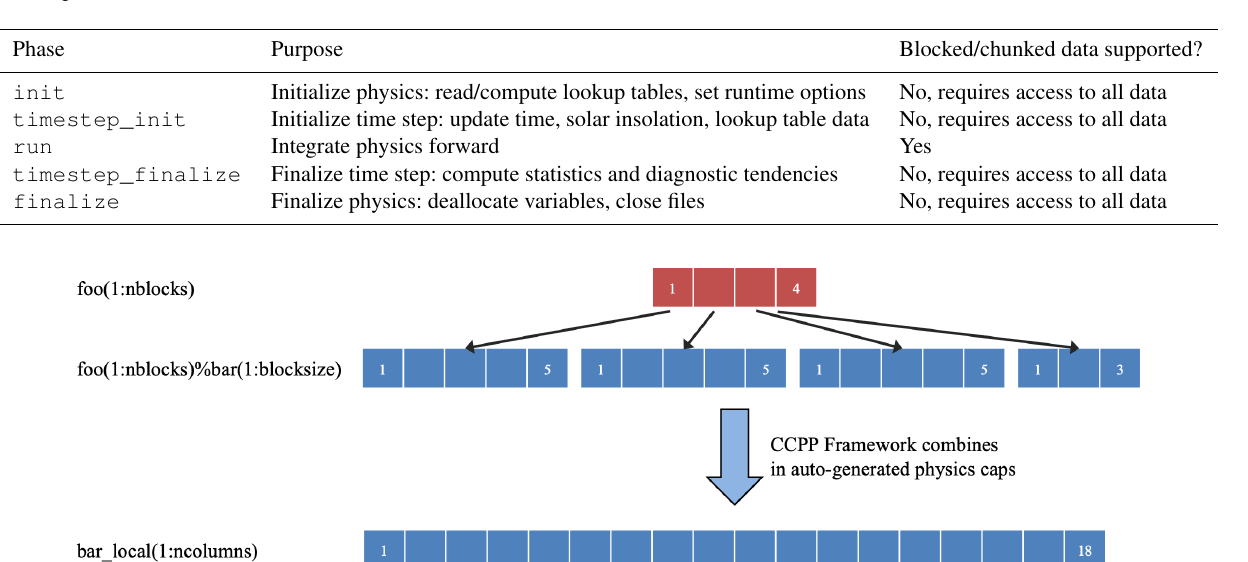
Table 1. Supported phases during a model run. The third column contains information on how blocked data structures are handled in the different phases.